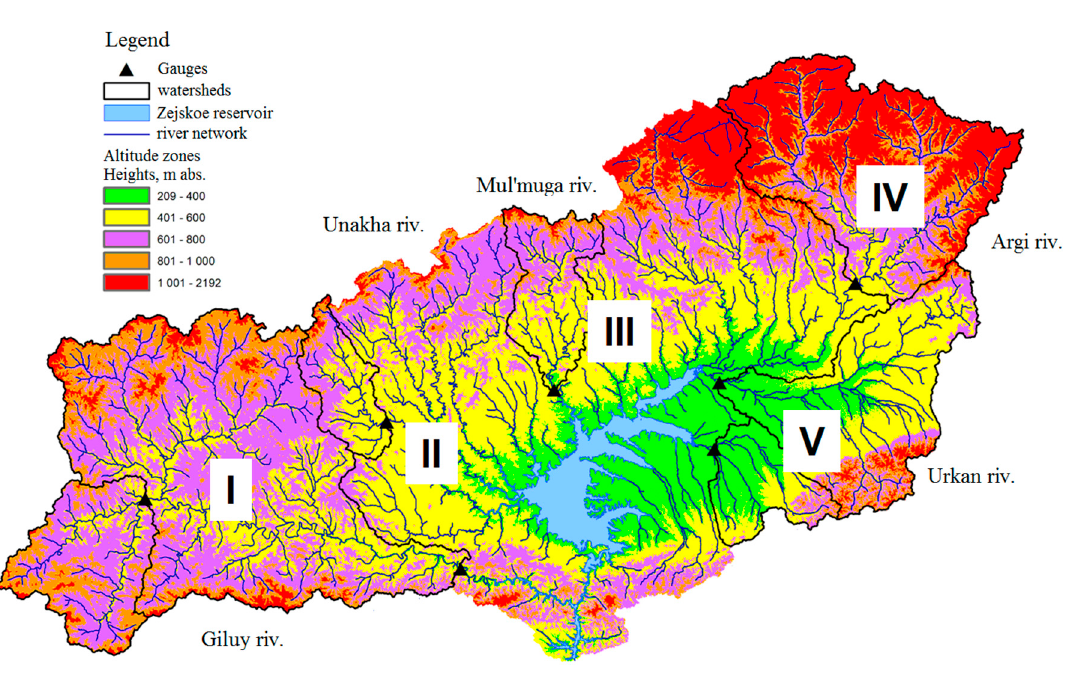
Figure 1. Landscape-hydrologic regionalization and elevation zoning of the Zeya reservoir watershed (numbers indicate the 5 subbasins, used as analogue river basins).